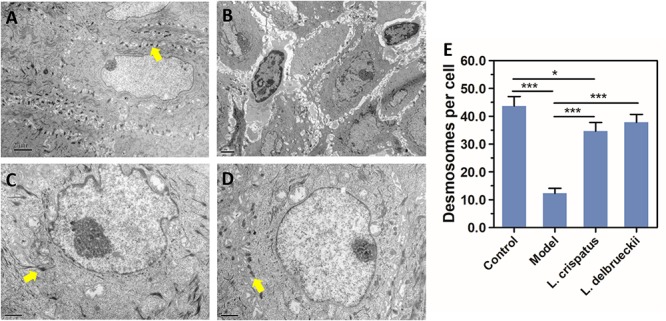
Desmosome quantification by TEM. Ultrastructure of desmosomes in the vaginal epithelium of rats observed by TEM. Control, uninfected (A); Model, infected with 1 × 108 CFU/ml C. albicans
(B);L. crispatus treated, infected and treated with L. crispatus 3.0 × 108 CFU for 7 days (C); L. delbrueckiitreated, infected and treated with L. delbrueckii 3.0 × 108 CFU for 7 days (D). The desmosome-like junctions (yellow arrow) are significantly diminished, and the space between adjoining epithelial cells is widened in Model rats. Number of desmosomes per cell (E) in normal Control, Model, L. crispatus treated and L. delbrueckiitreated rats. Data represent the mean ± standard deviation (n = 6). *P < 0.05; **P < 0.01; ***P < 0.001.